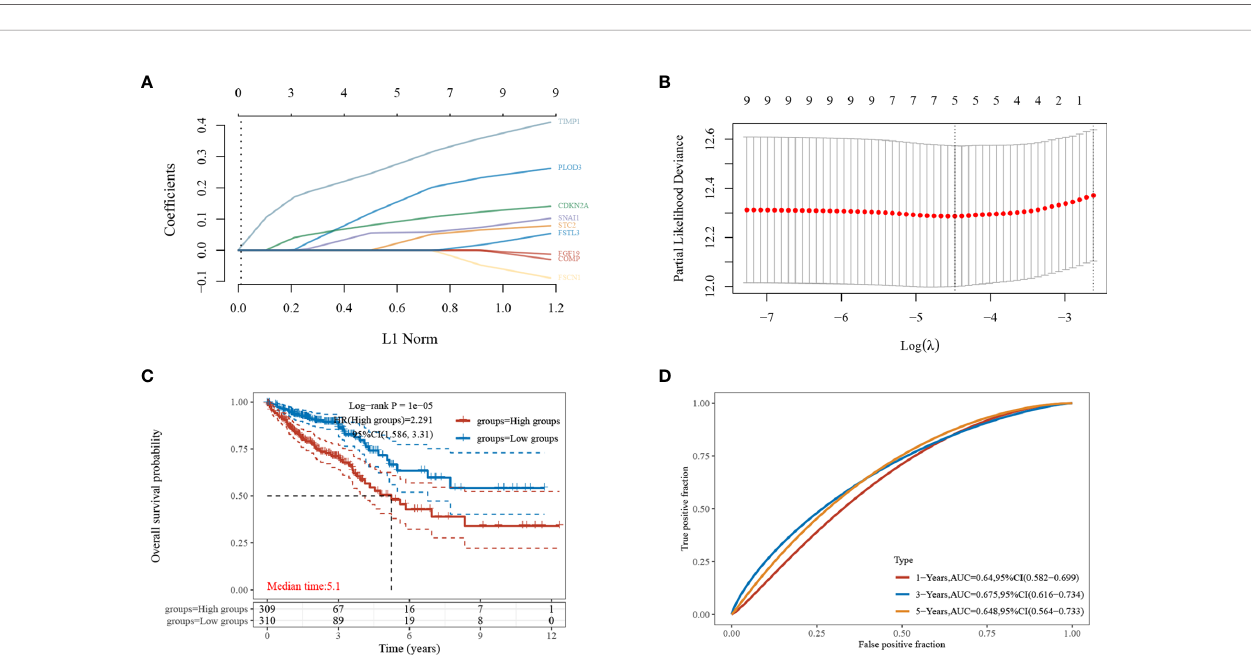
FIGURE 2 | Batch survival and expression analysis. (A) Results of batch survival analysis of overlapping genes, HR > 1 indicates that the gene is a protective factor for cancer; and (B) expression analysis of genes with survival signi fi cance. **P < 0.01, ***P < 0.001.